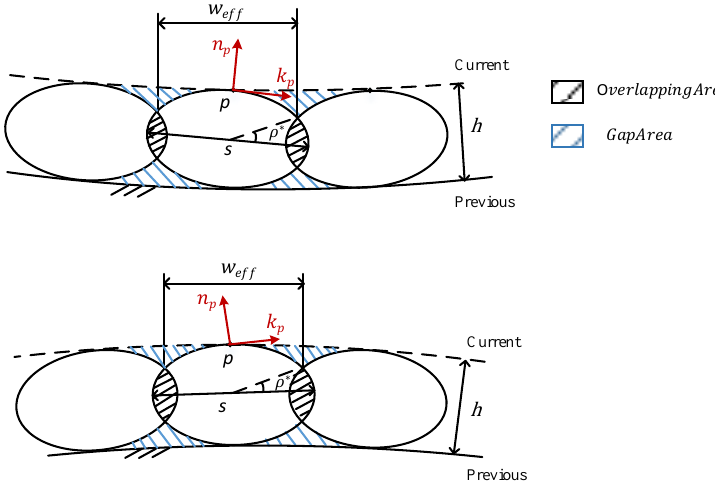
Figure 3. Gap-area equilibrium for the concave and convex